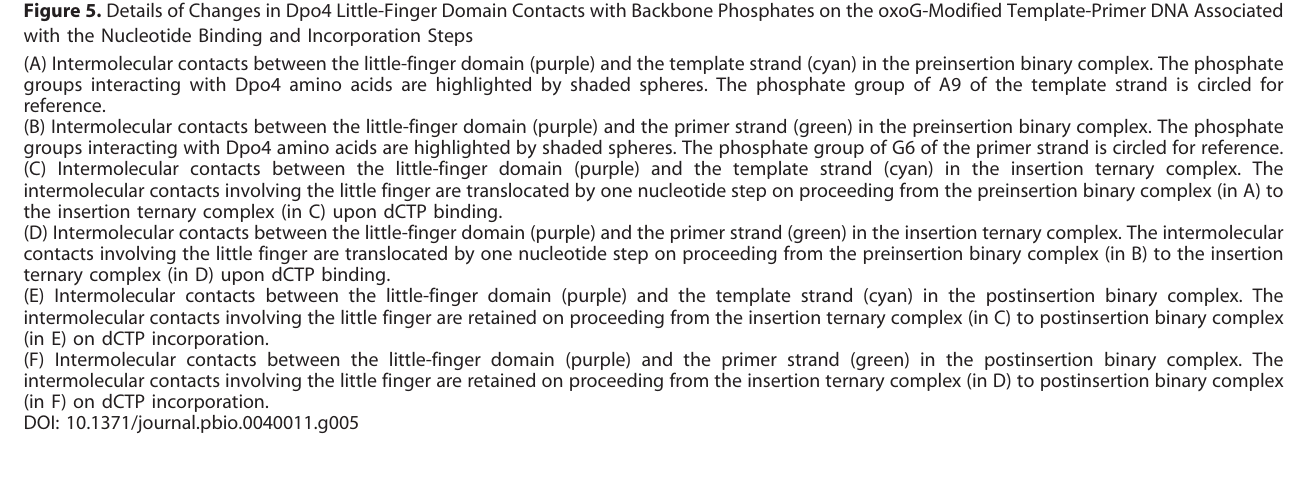
oxoG site (see Figure 2C) and forms a Watson-Crick traced in the electron density map. The finger domain is